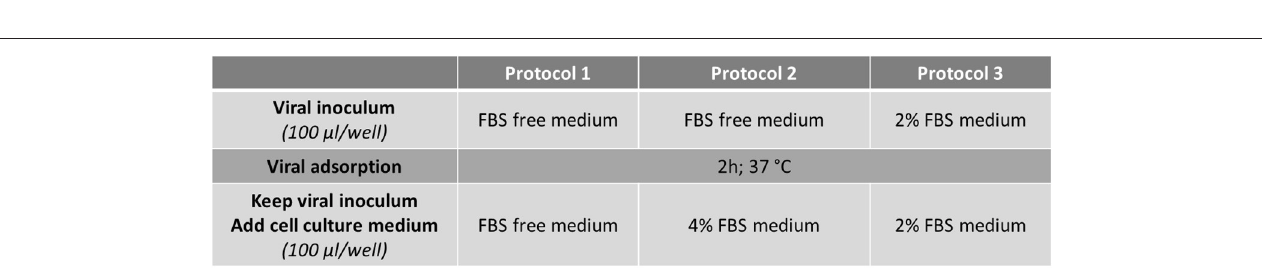
FIGURE 1 | Growth curves of FRhK-4 cells established using cell impedance measurements according to the cellular density at seeding. FRhK-4 cells were seeded in E-plate 96 at different cellular densities, from 625 to 80,000 cells per well, and Cell Index (CI) values were recorded with the DP xCELLigence system to obtain the ideal cell number and to determine the most suitable time point for virus infection.